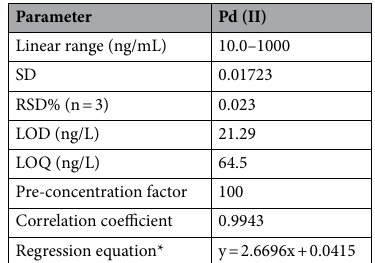
Table 4. The analytical characteristics of the method.